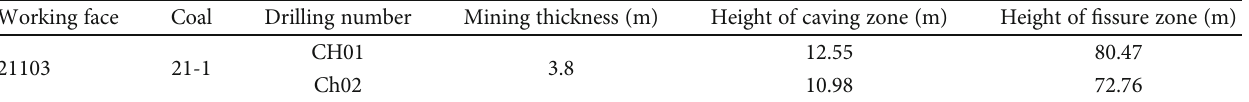
Table 3: Field drilling results of overburden fracture height in 21103 working face of 21-1 coal seam. Working